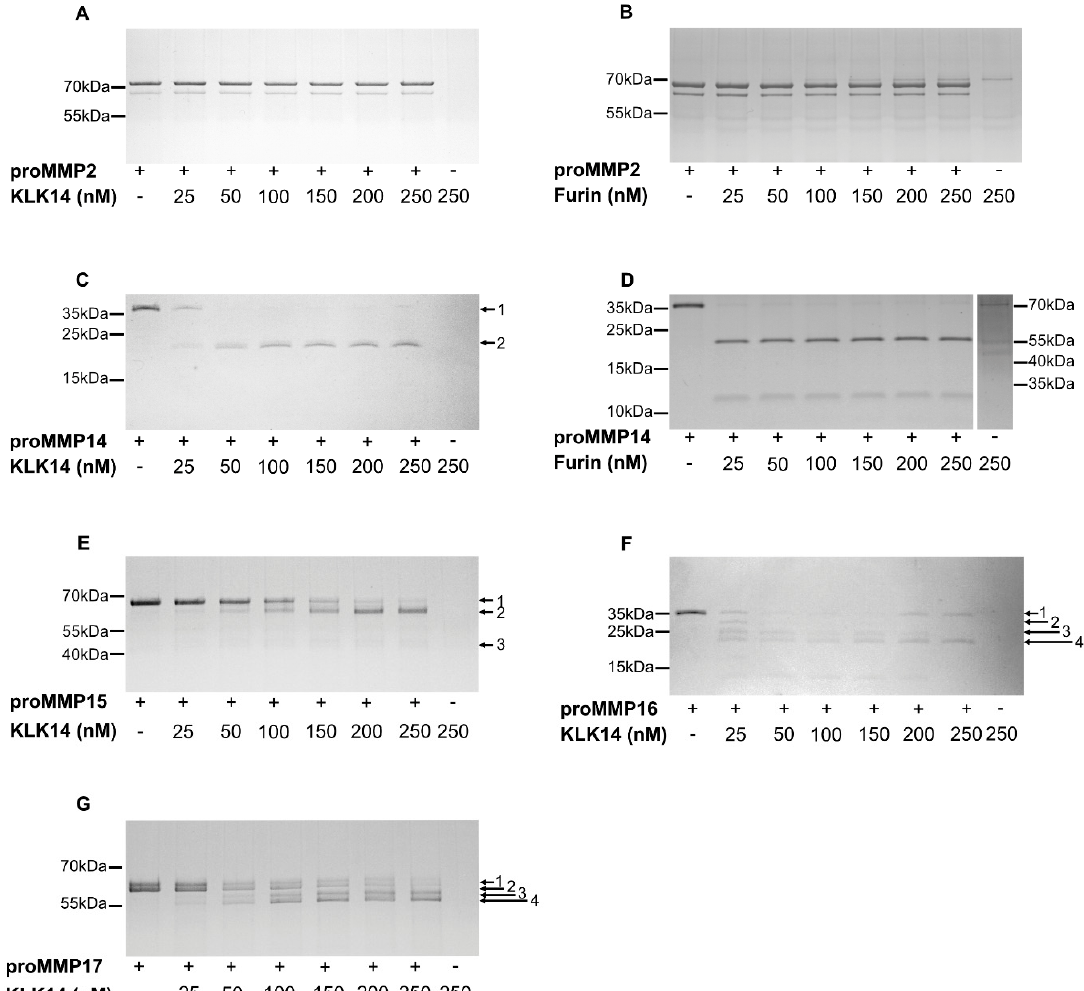
Figure 2. Concentration-dependent processing of proMMPs by KLK14. Each respective proMMP was incubated with increasing concentrations of KLK14 ( A,C,E – G ) or furin ( B,D ) for 1 h at 37 °C in the presence of 5 µM batimastat, and the reaction products were analyzed by SDS-PAGE and visualized with Coomassie staining. Bands denoted with arrows were identified by N-terminal sequencing using Edman degradation (Table 2). KLK = kallikrein-related peptidase; MMP = matrix metalloproteinase.